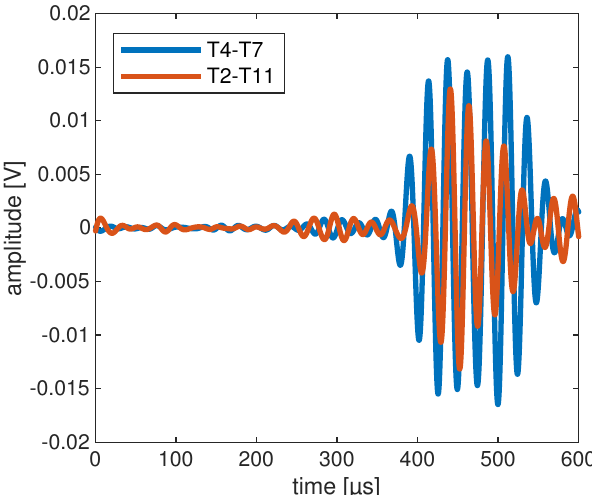
Figure 21. Exemplary differential signals of the OGW data set for a damage of size 671 mm 2 at position D1 and the mentioned actuator-sensor